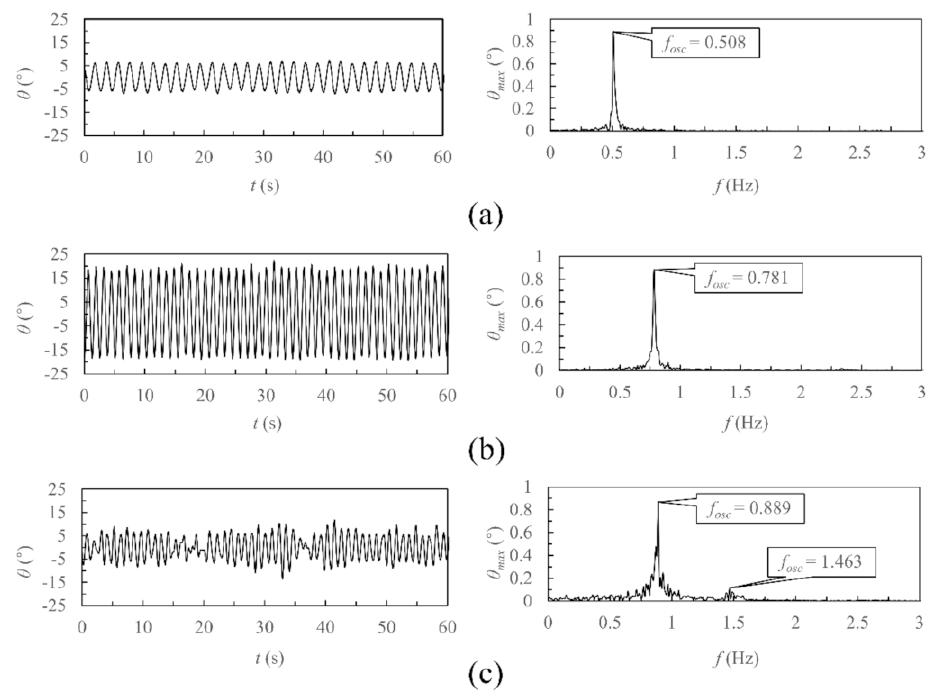
Figure 16. Rotational oscillation time history and spectral characteristics at three typical velocities when L / D = 5.5: ( a ) U = 0.302 m/s ( U r = 2.975); ( b ) U = 0.556 m/s ( U r = 5.483); ( c ) U = 0.810 m/s ( U r =